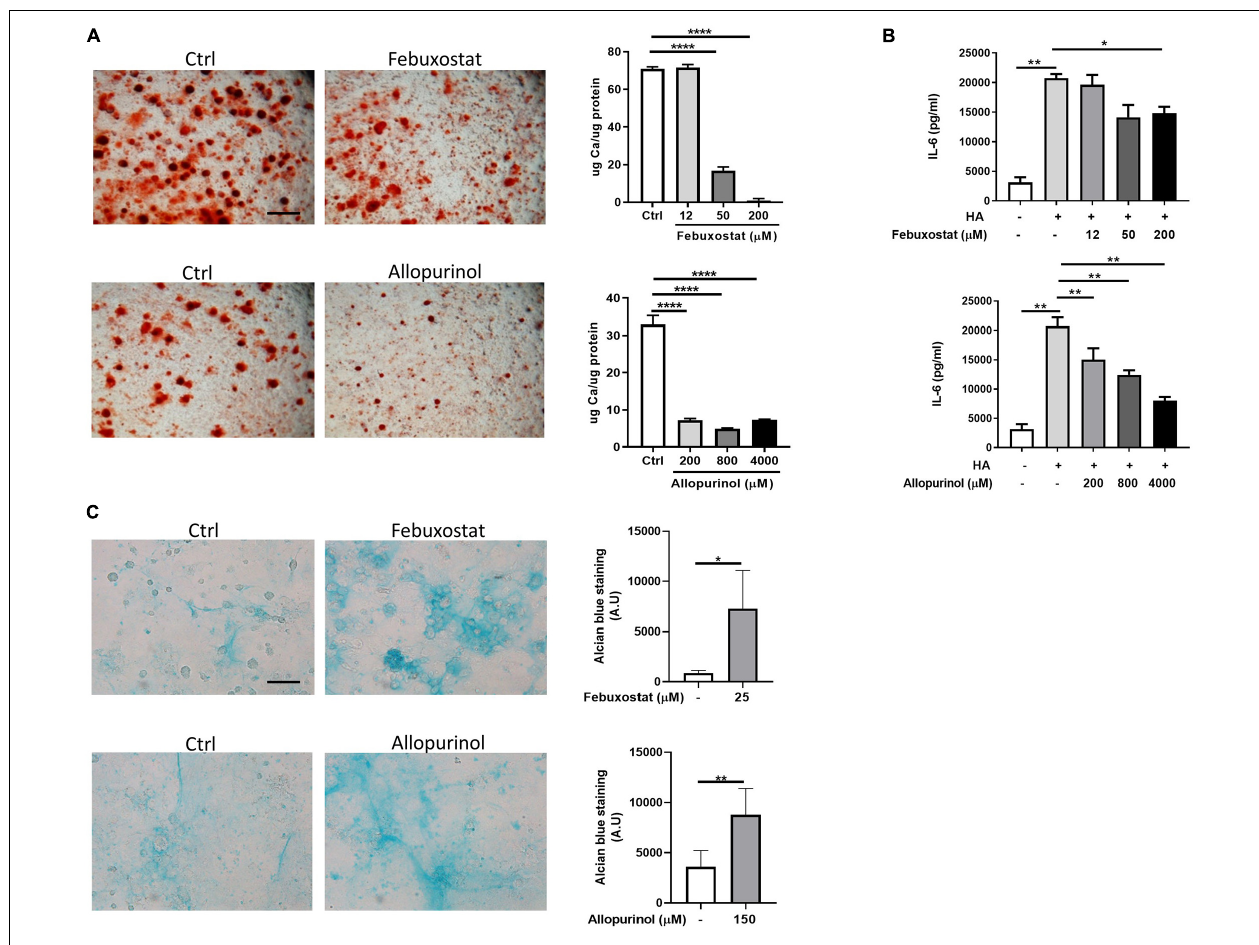
FIGURE 2 | Xanthine oxidoreductase inhibitors regulate chondrocytes mineralization, IL-6 secretion, and extracellular matrix glycosaminoglycan content. (A) Representative Alizarin red staining of murine primary chondrocytes cultured with CPP and treated with 200 µ M Febuxostat or 4 mM Allopurinol for 24 h. Pictures represent triplicates from one experiment of three independent experiments. Scale bar 400 µ M. Graphs represent calcium content in the cell monolayer of chondrocytes cultured with CPP and treated with different doses of Febuxostat and Allopurinol for 24 h, expressed as µ g Ca/ µ g protein. ∗∗ p < 0.01, ∗∗∗ p < 0.001, ∗∗∗∗ p < 0.0001. (B) IL-6 secretion in cell supernatant of chondrocytes stimulated for 24 h with HA crystals and different doses of Febuxostat or Allopurinol. ∗ p < 0.05, ∗∗ p < 0.01. (C) Representative Alcian blue staining of chondrocytes treated with 25 µ M Febuxostat or 125 µ M Allopurinol for 10 days. Pictures represent triplicates from one experiment of two independent experiments. Scale bar 100 µ M. Graphs represent quantification of Alcian blue staining in the cell monolayer. ∗ p < 0.05, ∗∗ p <